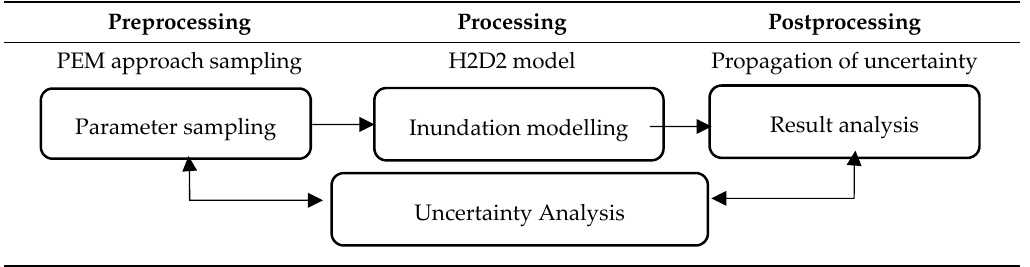
Table 1. General procedure for uncertainty analysis based on point estimate method (PEM) simulations.